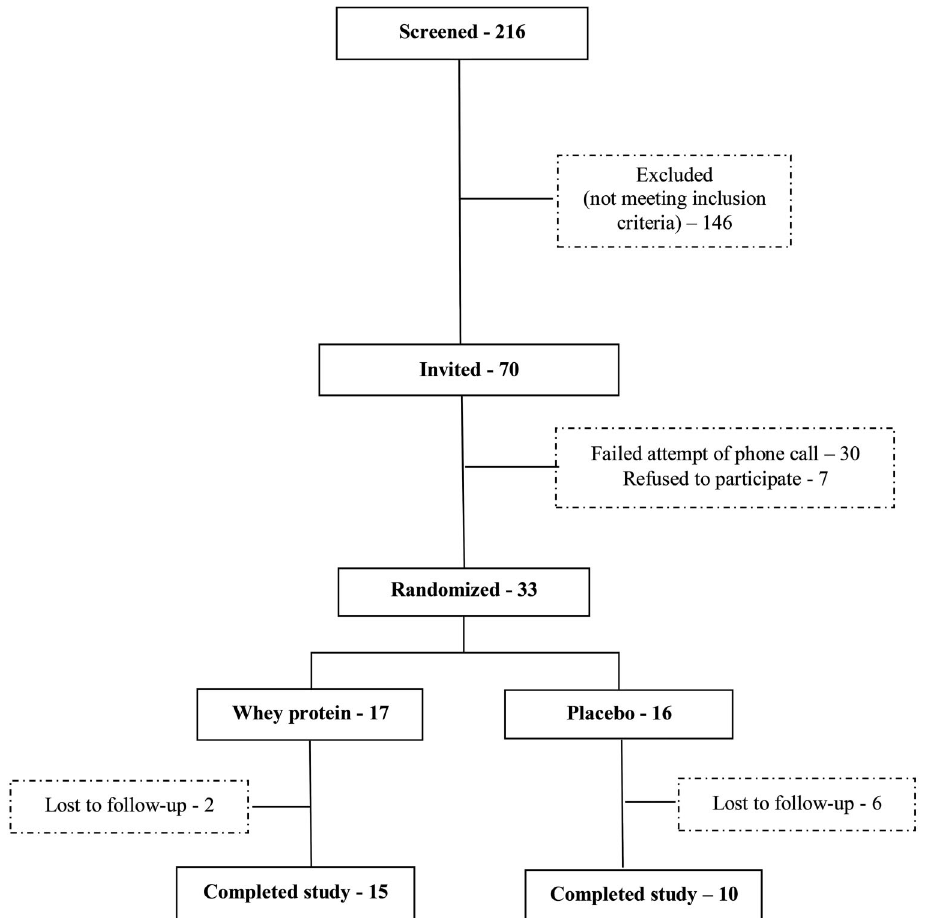
Figure 1. Flow chart of the selection of study